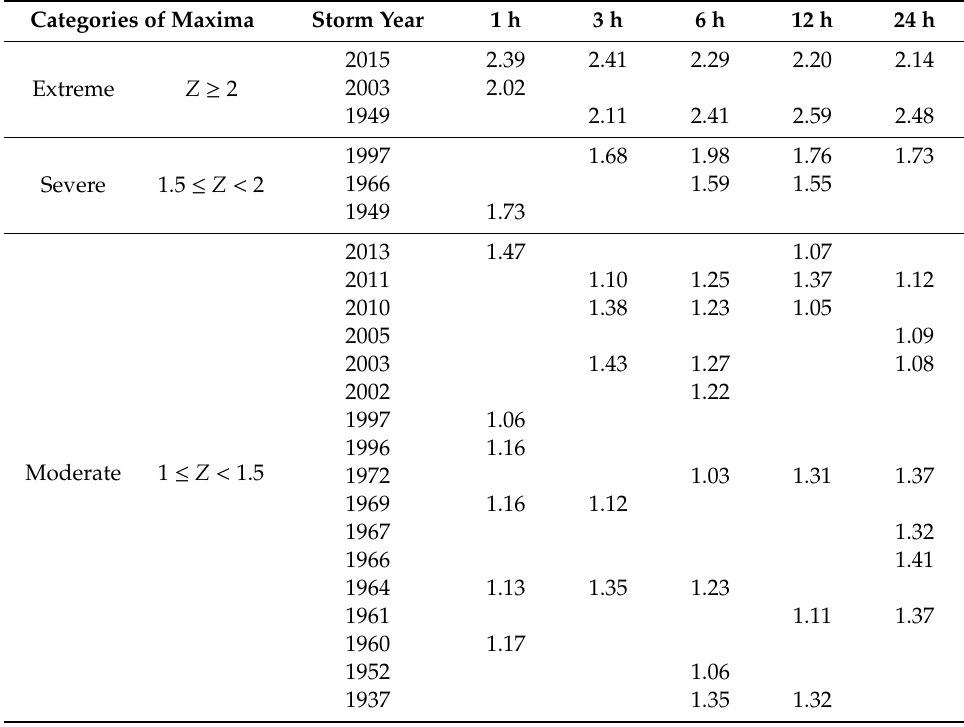
Table 1. Z values for the most intense storms recorded in the Tammaro